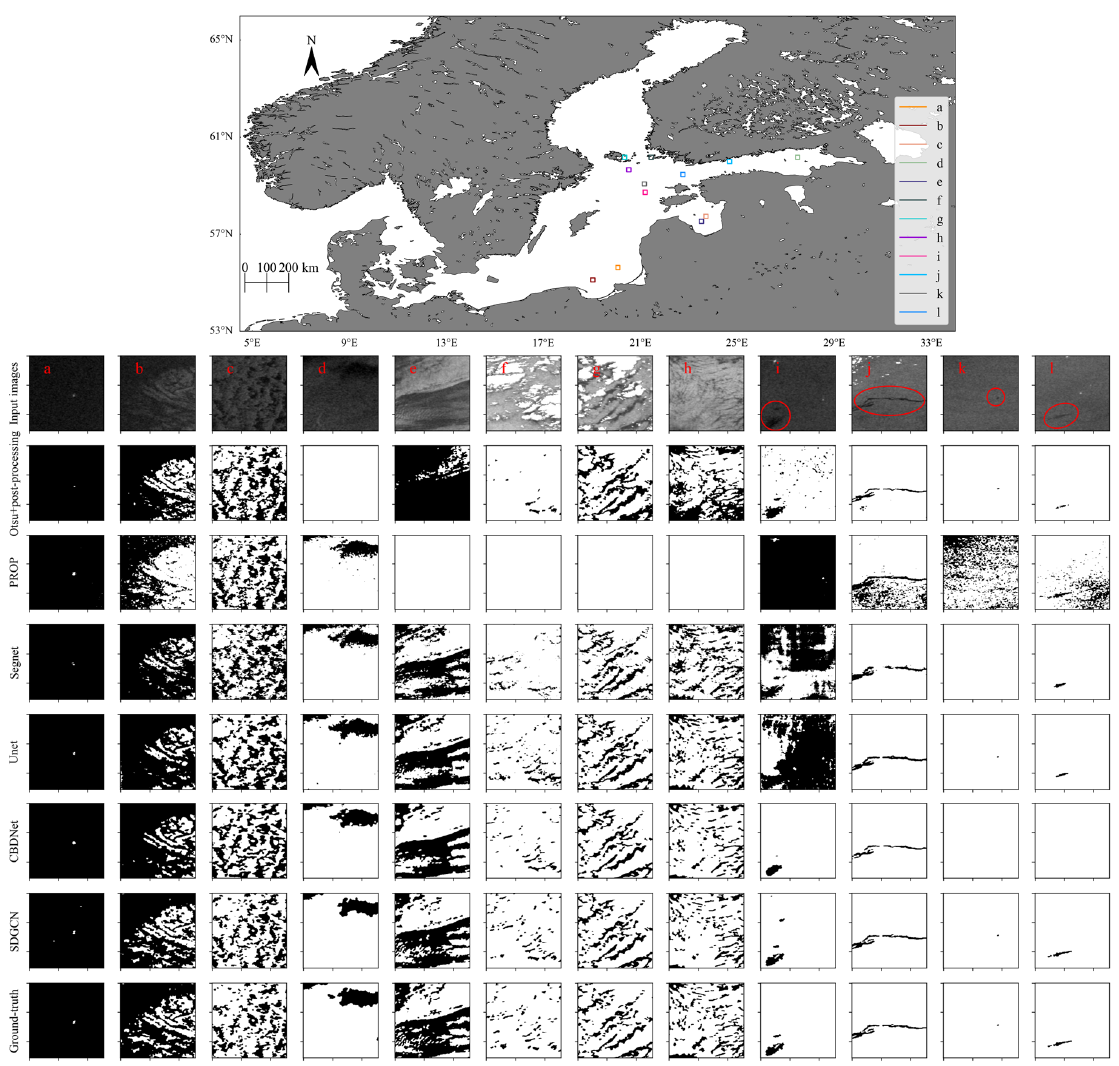
Figure 5. A few examples of qualitative comparison results. a~l are the various SAR images (256 × 256 pixels) that were used. The top panel shows the locations of images a~l, respectively. Images a~h contain lookalikes of varying shapes and sizes, with images a~d being darker and images e~h being brighter. The red regions in the SAR images a through h depict oil slicks of varied shapes and sizes.